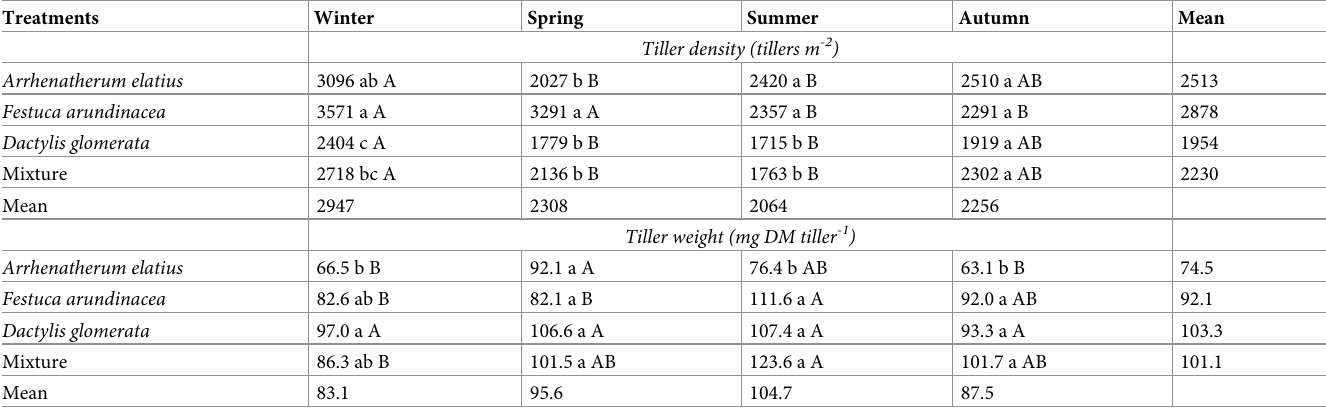
Table 1. Tiller density and tiller weight of Arrhenatherum elatius , Festuca arundinacea , and Dactylis glomerata swards sowed as monoculture or as a mixture throughout the seasons. Treatments